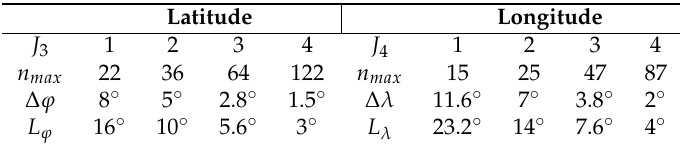
Table 2. Values for the B-spline levels J 3 and J 4 , the maximum SH degree n max , the input data